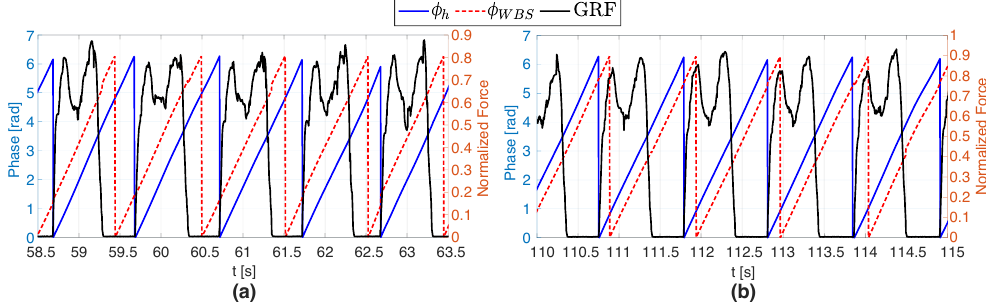
Figure 4. Effects of the closed-loop stimulation on the gait of a representative participant. The black line represents the normalized ground reaction force (GRF) extracted from the multi-cell piezo-resistive sensor. If the user’s current walking speed ( SV h ) is slower than the target speed ( SV T ) set by the experimenter, the stimuli anticipate the IC to encourage a faster pace ( a ); Conversely, if SV h is faster than SV T , the stimuli lag the IC, to elicit a slower pace ( b